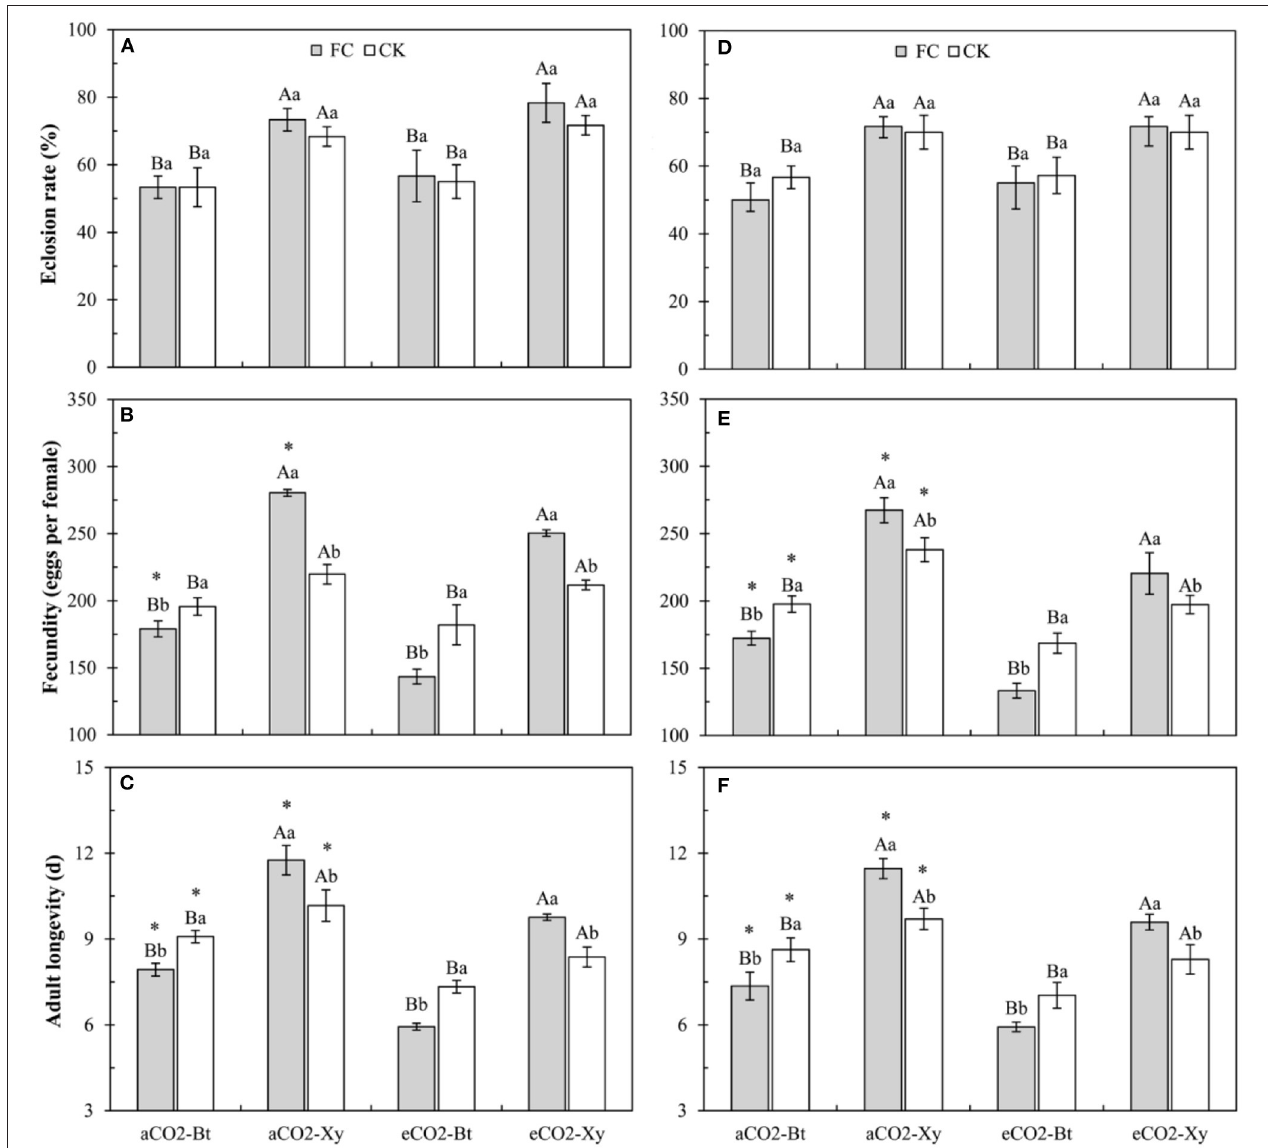
FIGURE 6 | Effects of the inoculation with arbuscular mycorrhizal fungi (AMF), F. caledonium , on the growth and development of M. separata adults fed on Bt maize (Bt) and its parental line of non- Bt maize (Xy) under ambient CO 2 ( a CO 2 ) and elevated CO 2 ( e CO 2 ) at the heading stage (BBCH-59) in 2017 (A–C) and 2018 (D–F) . (Note: the same as Figure 3 ) ( P < 0.05; n =